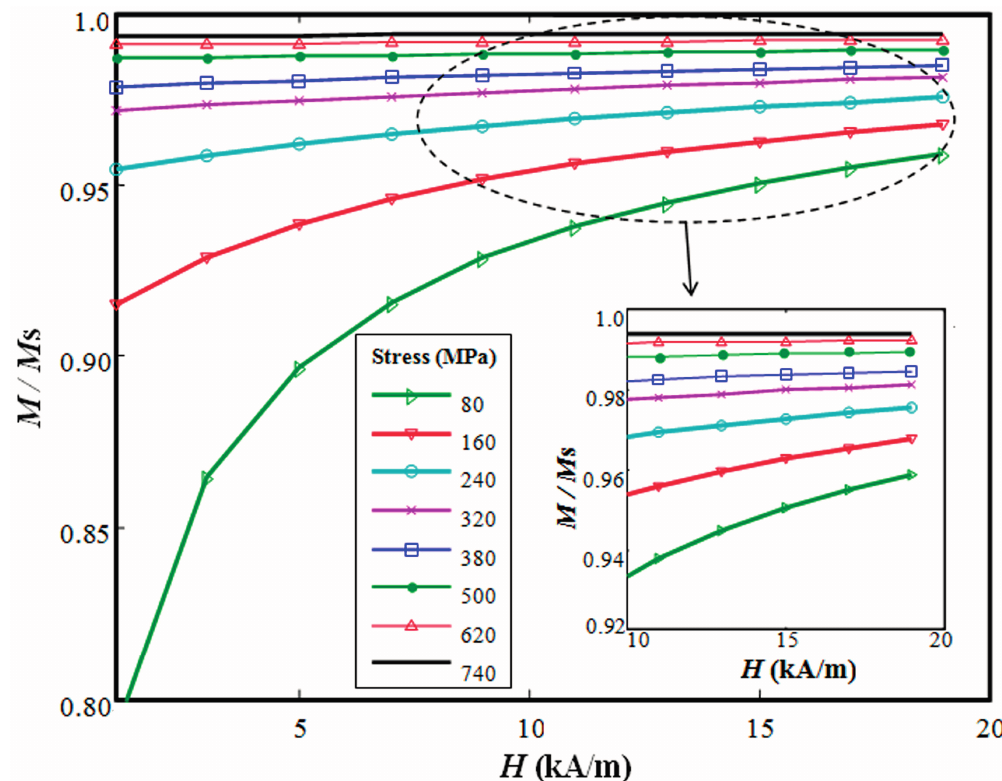
= 1.7 × 10 6 A/m, S (0) 1